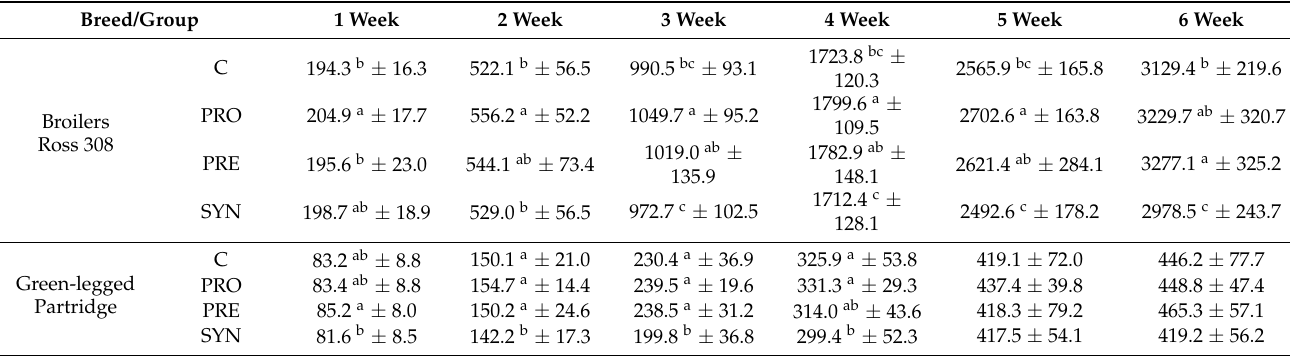
Table 2. Body weight of broiler chickens and green-legged partridge chickens during the production period (means ± SD).